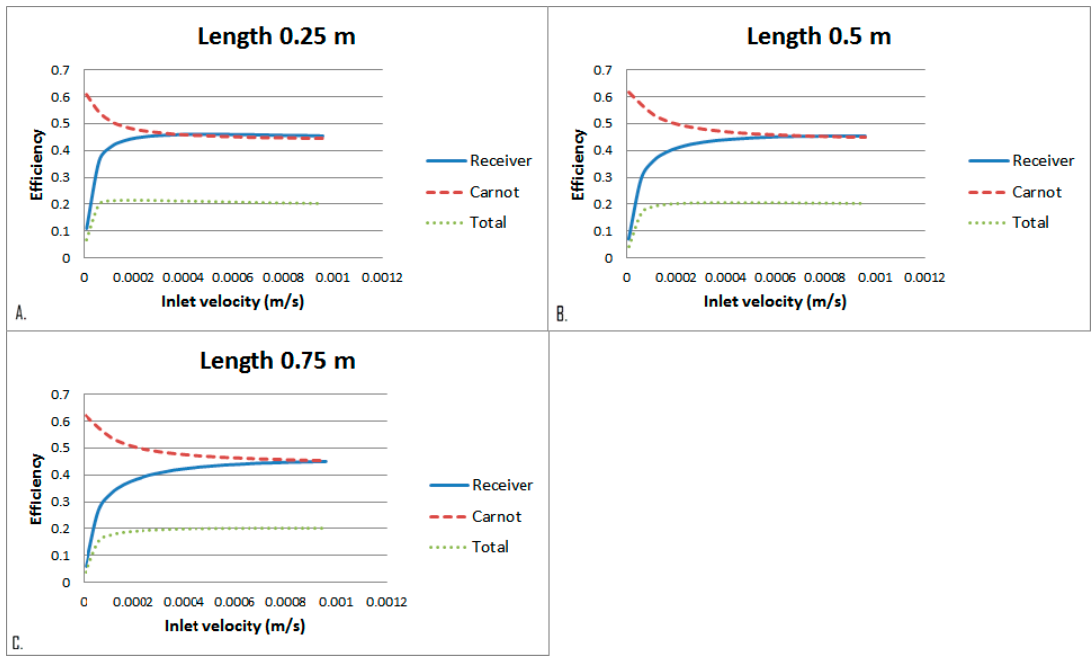
Figure 14. Inlet velocity comparison at different receiver lengths. A . 0.25 m, B . 0.5 m, C . 0.75